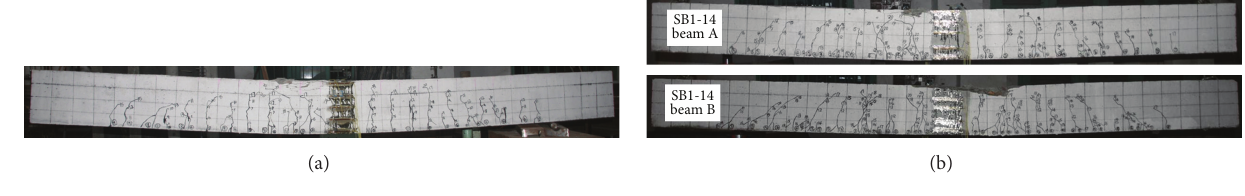
Figure 4: Damage patterns of the beams: (a) RB-14 and (b)